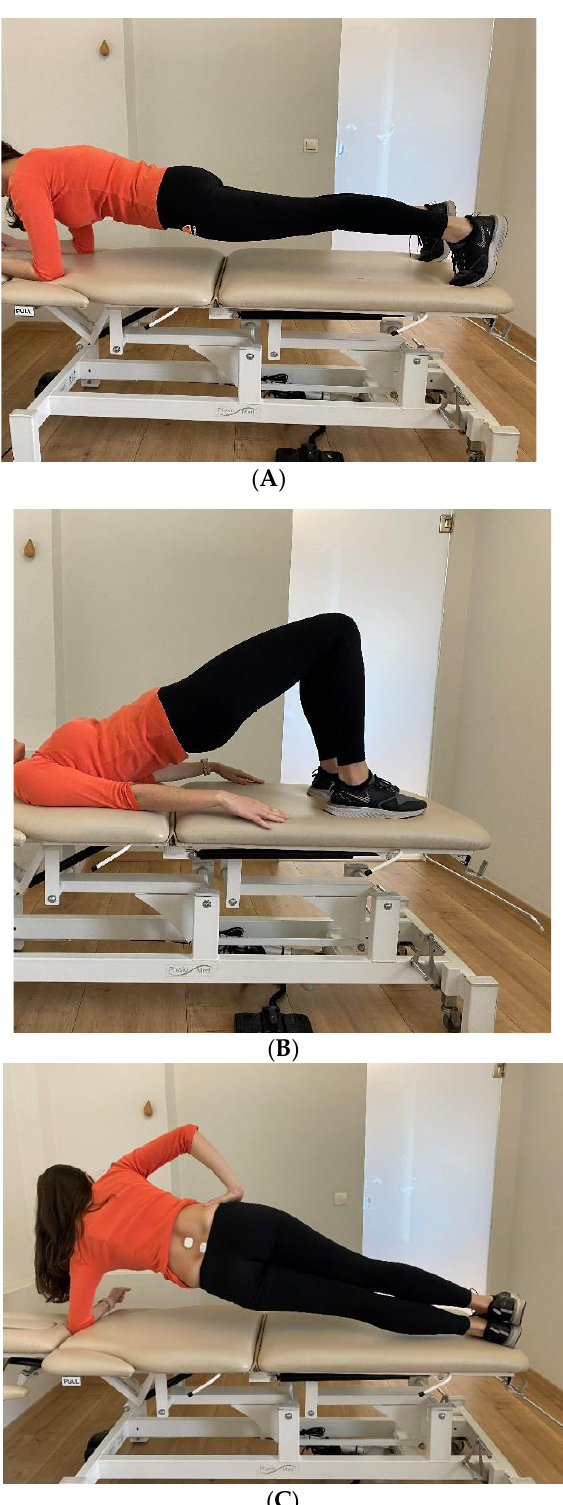
Figure 2. ( A ) Prone bridge test end position . ( B ) Supine bridge test end position. ( C ) Left-side bridge test end